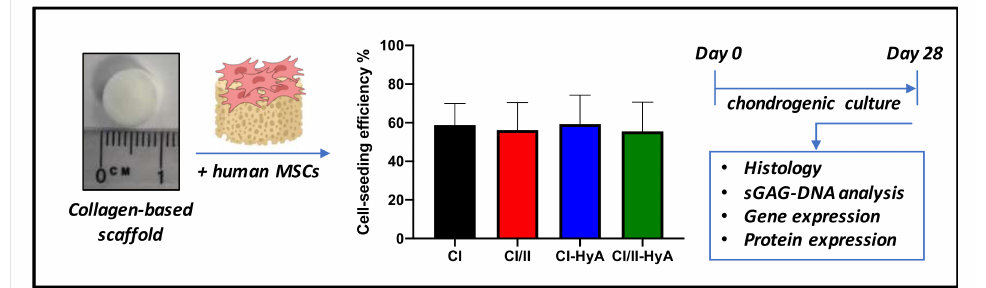
Figure 1. Illustrative scheme describing the experimental design. Collagen-based scaffolds were seeded with human MSCs and processed for histological, sGAG/DNA and gene/protein expression analysis after 28 days in